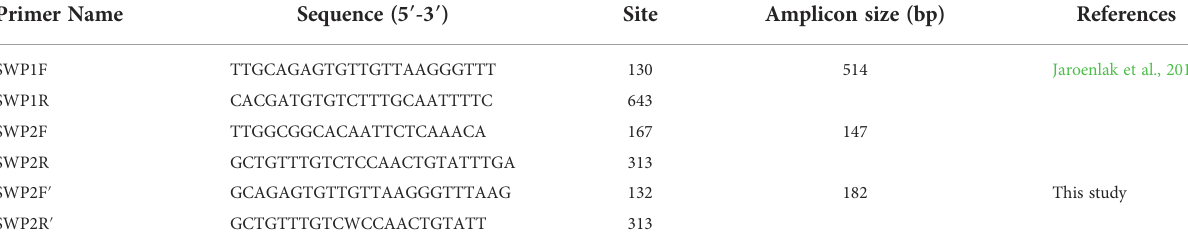
TABLE 1 Primers for PCR